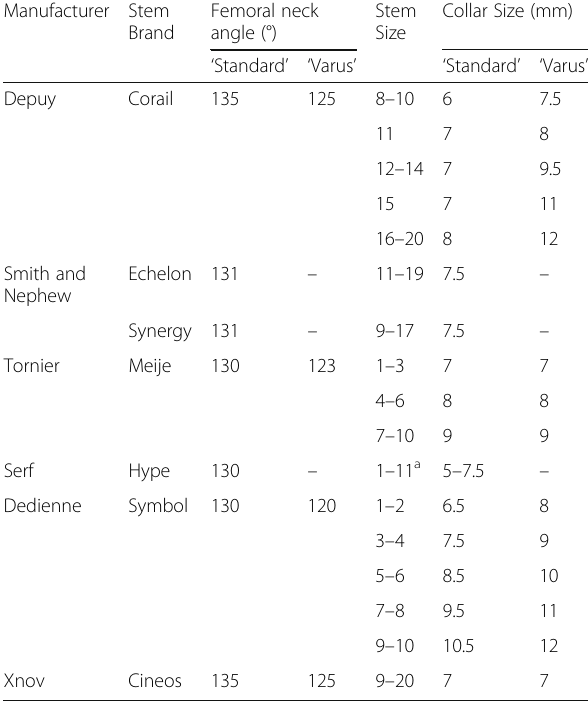
Table 3 Design characteristics of uncemented collared femoral stems by different